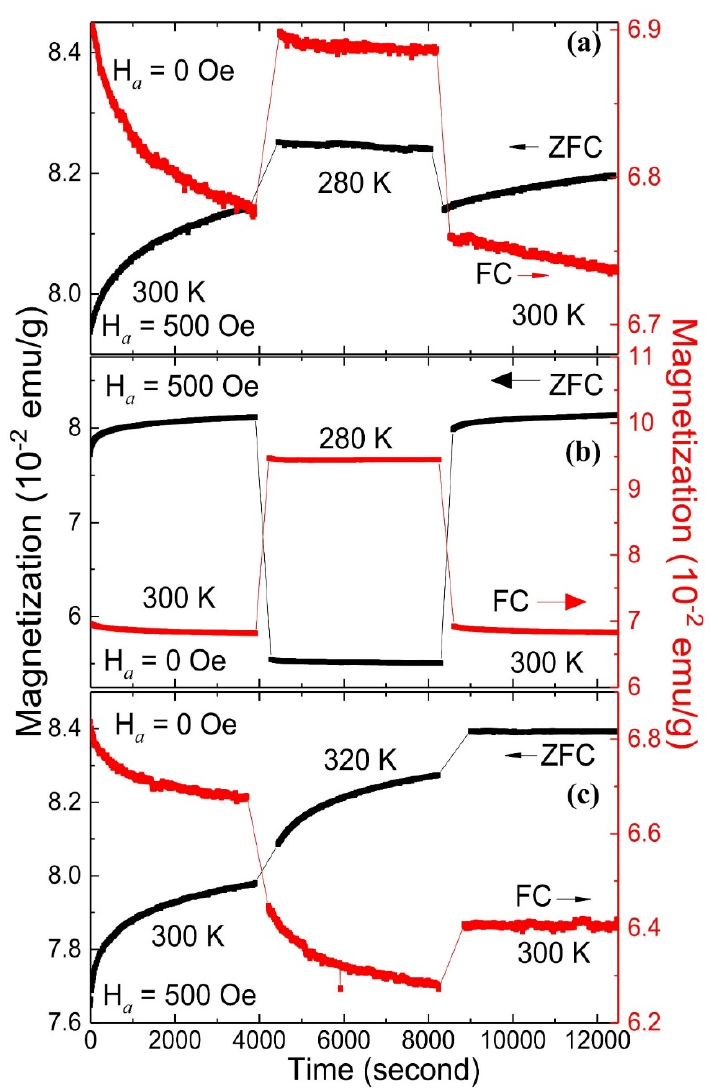
Figure 7. The effect of temperature-cooling ( a ) without ( b ) with field switching and ( c ) temperature-heating cycle without field switching during ZFC and FC magnetization relaxation from 1% sample.